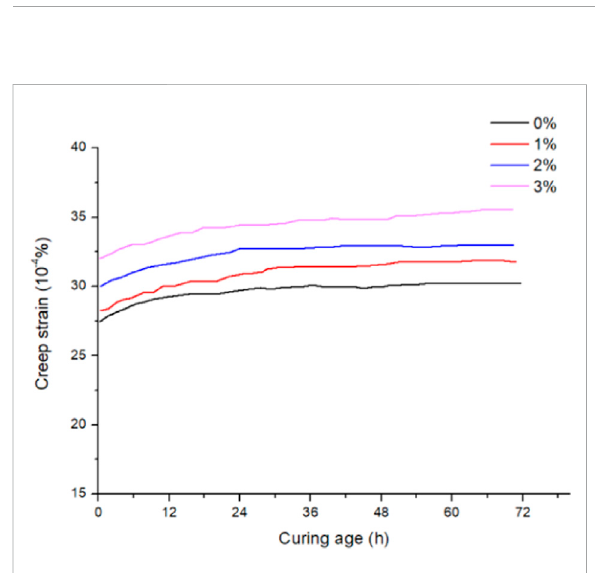
FIGURE 1 Effect of retarder content on creep deformation of oil well cement.